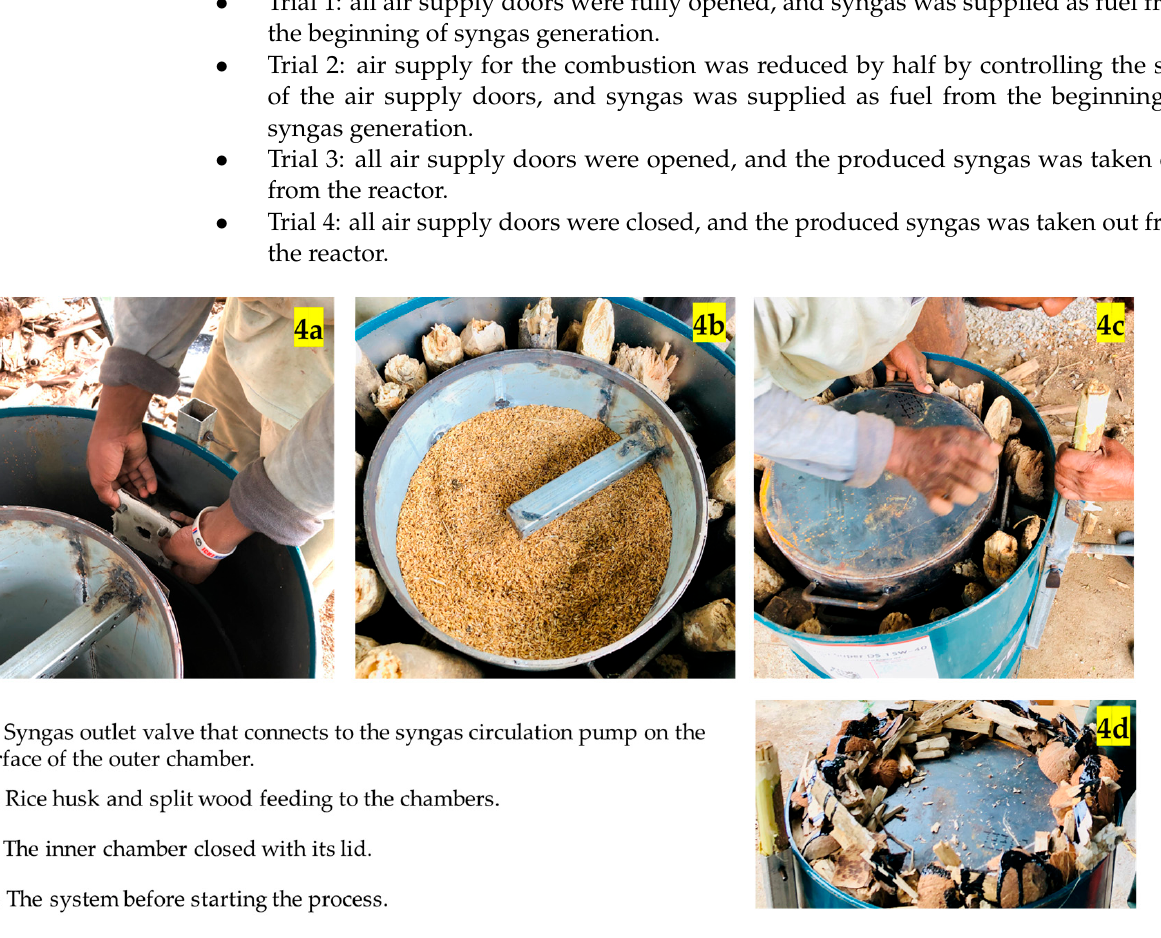
Figure 4. Dual-chamber pyrolizer start-up process.